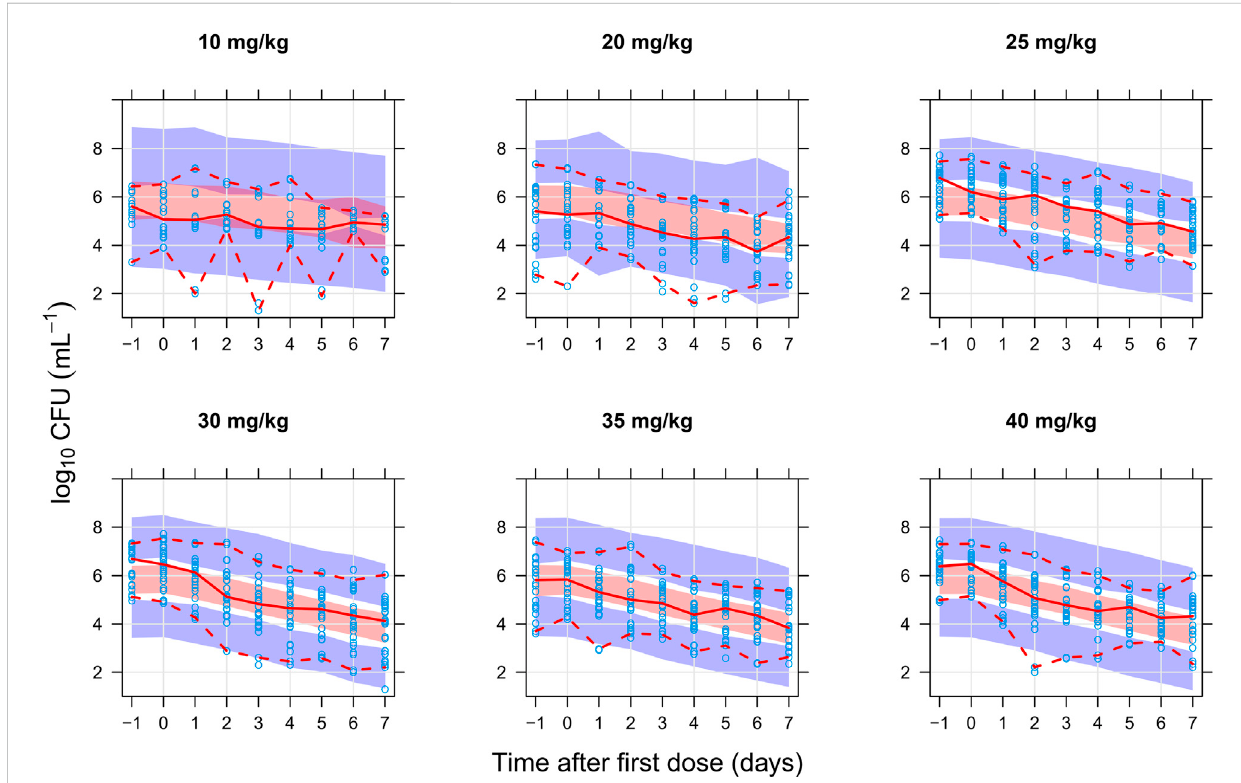
Visual predictive check of the fi nal quantitative biomarker model describing colony forming unit (CFU) versus time since fi rst dose and strati fi ed on rifampicin dose group. The solid and dashed lines are the median, 2.5th, and 97.5th percentiles of the observed data, respectively. The shaded areas are the95%con fi denceintervalsofthe97.5th(blue),median(red),and2.5th(blue)percentilesofthesimulateddatabasedon1,000simulations.Opencircles are the